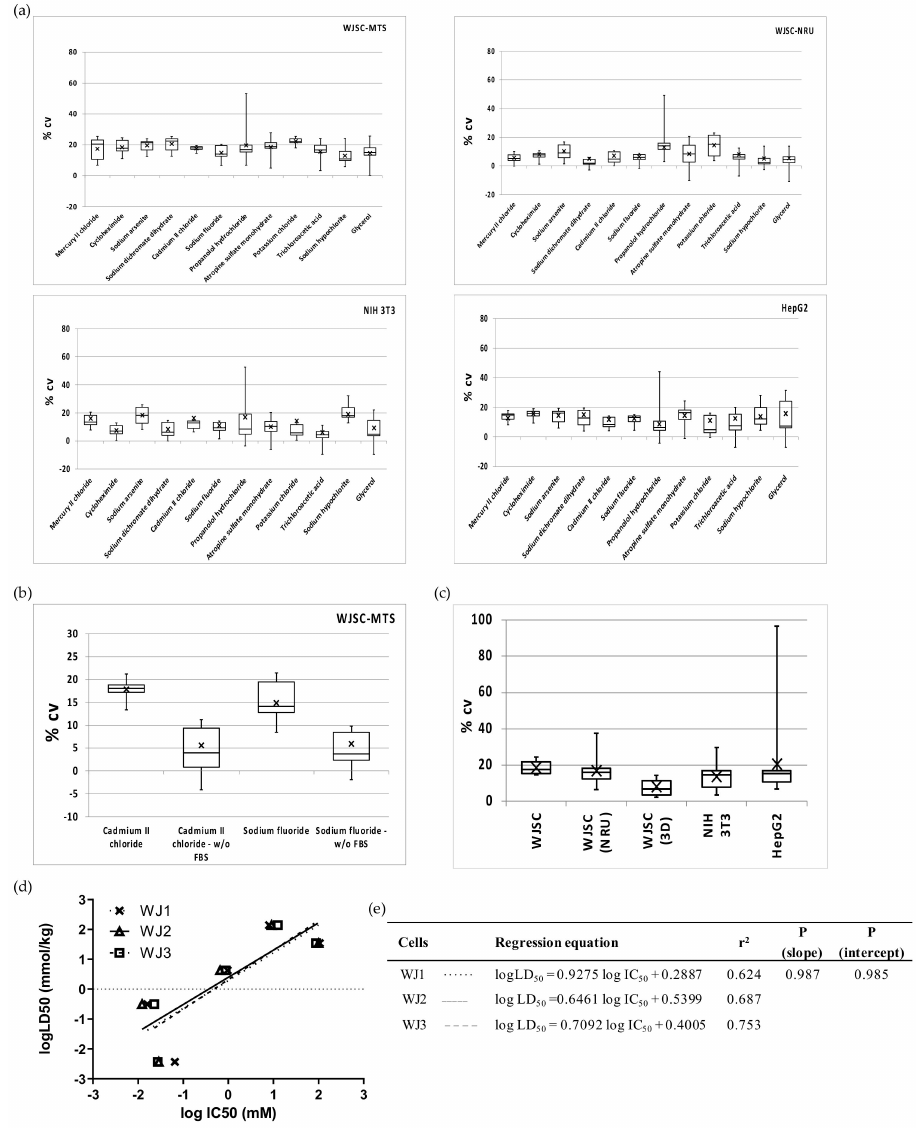
Figure 5. Precision of the WJSC-based toxicity assay: ( a ) Intra-assay variations (%CV within each MTP/for each chemical) of 2D culture assays for WJSC, NIH 3T3 and HepG2 cells. Chemicals are listed on the x axis in descending order of cytotoxicity. Cell viability/toxicity in WJSCs was estimated using either the MTS (upper left) or the NRU (upper right) assays, while in both NIH 3T3 and HepG2 cells the MTS assay was employed (down). ( b ) Effect of FBS on intra-assay variation of the WJSC-MTS assay; two chemicals were used—cadmium(II) chloride and sodium fluoride, p < 0.001 standard culture vs. no FBS, for both chemicals. ( c ) Inter-assay variation calculated at IC 50 ( n = 12 in all cases, apart from 3D culture, where n = 7). ( d ) Inter-culture variation in the WJSC cytotoxicity screening assay. The linear regressions for five selected chemicals (mercury(II) chloride, sodium arsenite, sodium fluoride, potassium chloride, and sodium hypochlorite) are shown in comparison of human fetal WJSCs derived from three different donors (WJSC #1, WJSC #2, WJSC #3). Regression lines are plotted as a dotted line with data points marked as “x” symbols, a solid line with open triangles, and a dashed line with open squares for WJSC #1, WJSC #2, and WJSC #3, respectively. ( e ) Regression parameters in tabular format for each of the regression graphs. The three regressions did not differ significantly ( p > 0.05,